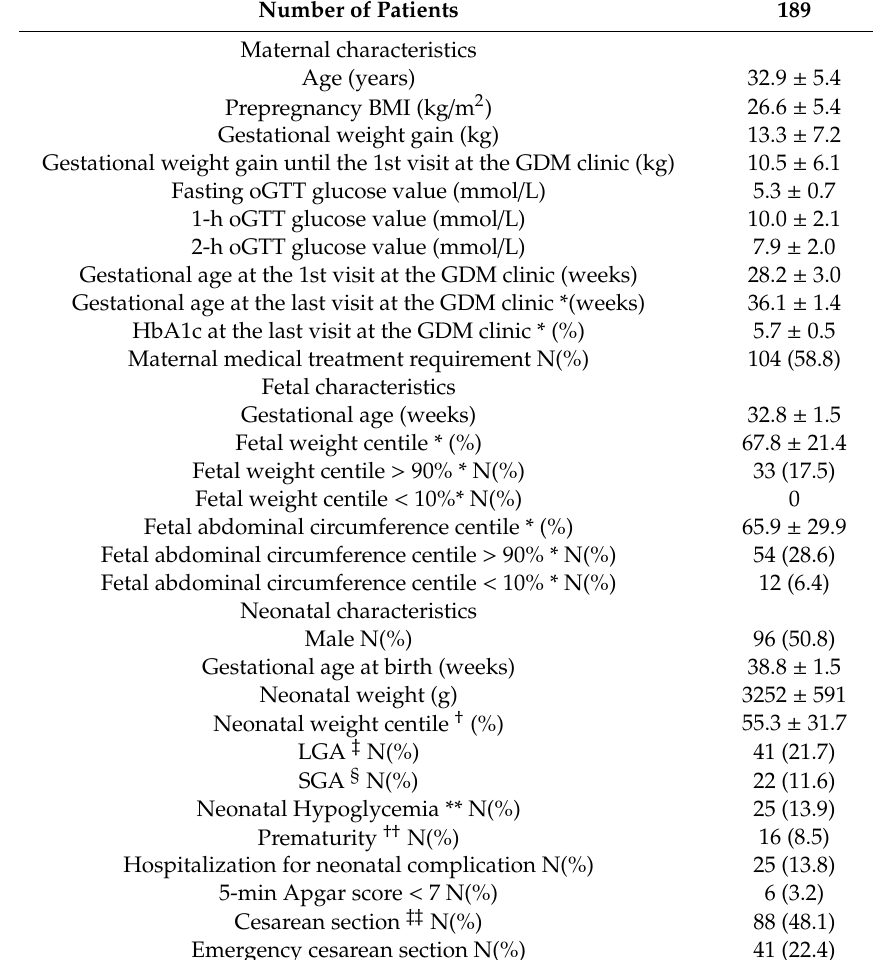
Table 1. Descriptive maternal, fetal and neonatal